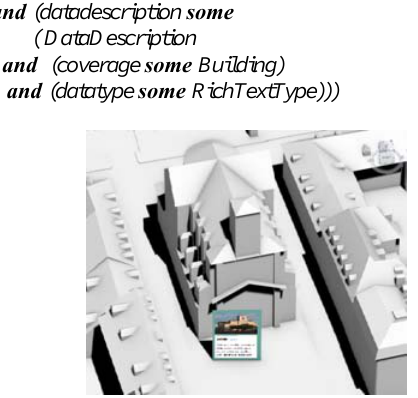
Figure 8. A technique for the visualization of rich text panels